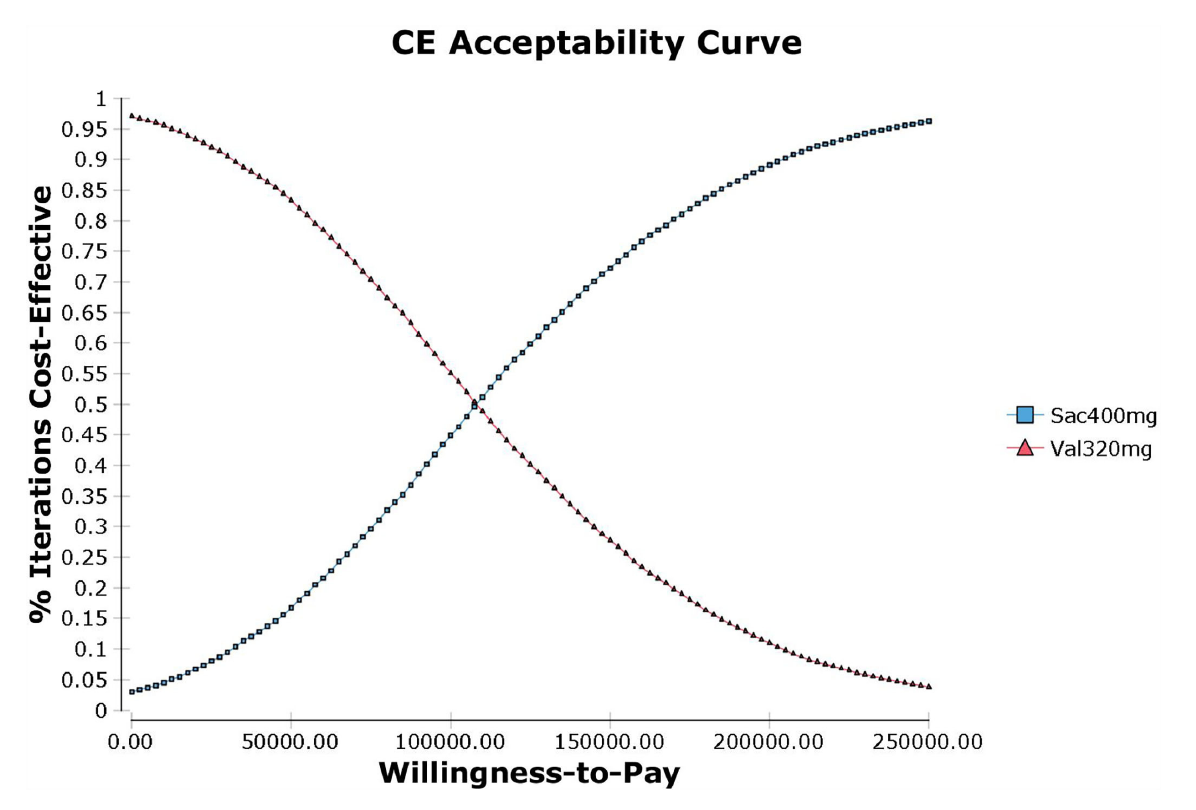
FIGURE5 Cost-effectiveness acceptability curve of sacubitril-valsartan vs. valsartan in treating hypertension in China setting. When the WTP is 108,200 CNY/QALY (1.34 times of per capita GDP in China in 2021), sacubitril-valsartan and valsartan share a similar